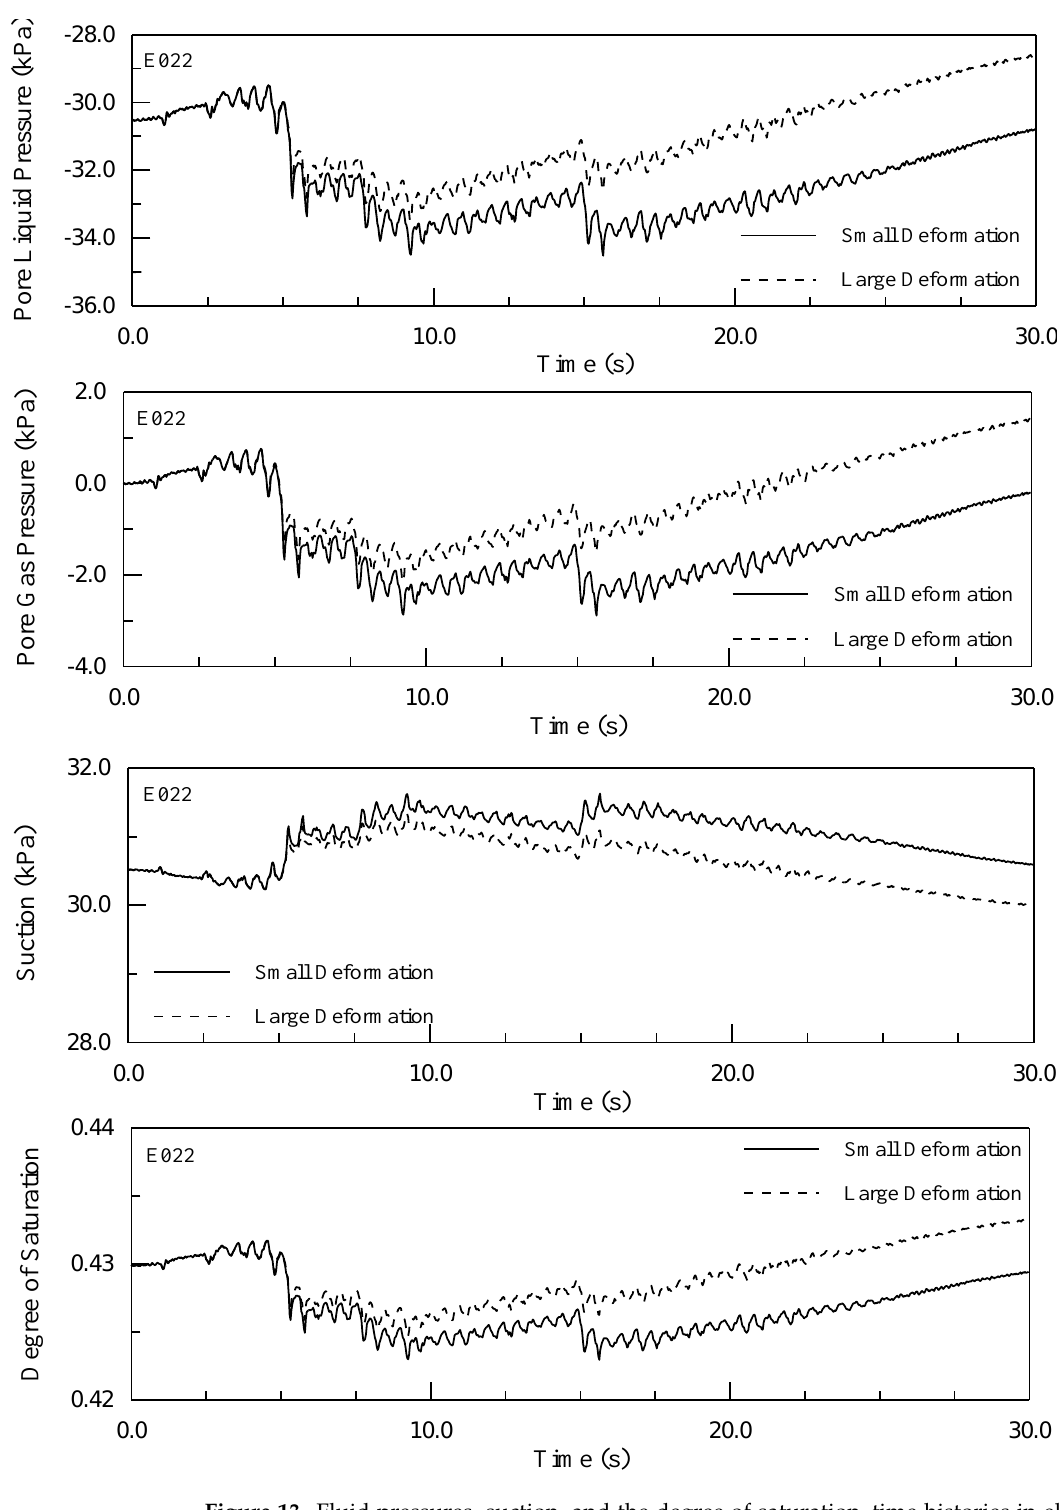
Figure 13. Fluid pressures, suction, and the degree of saturation – time histories in element E022 – severe shaking.